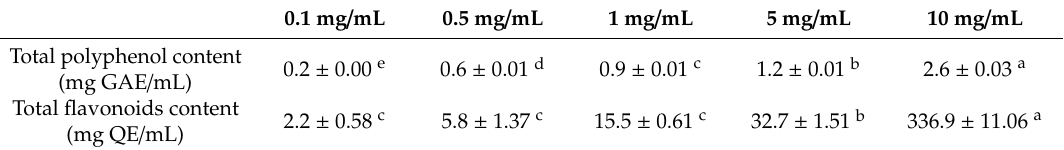
Table 4. Total polyphenol and flavonoid contents of A. koraiensis ethanol extracts